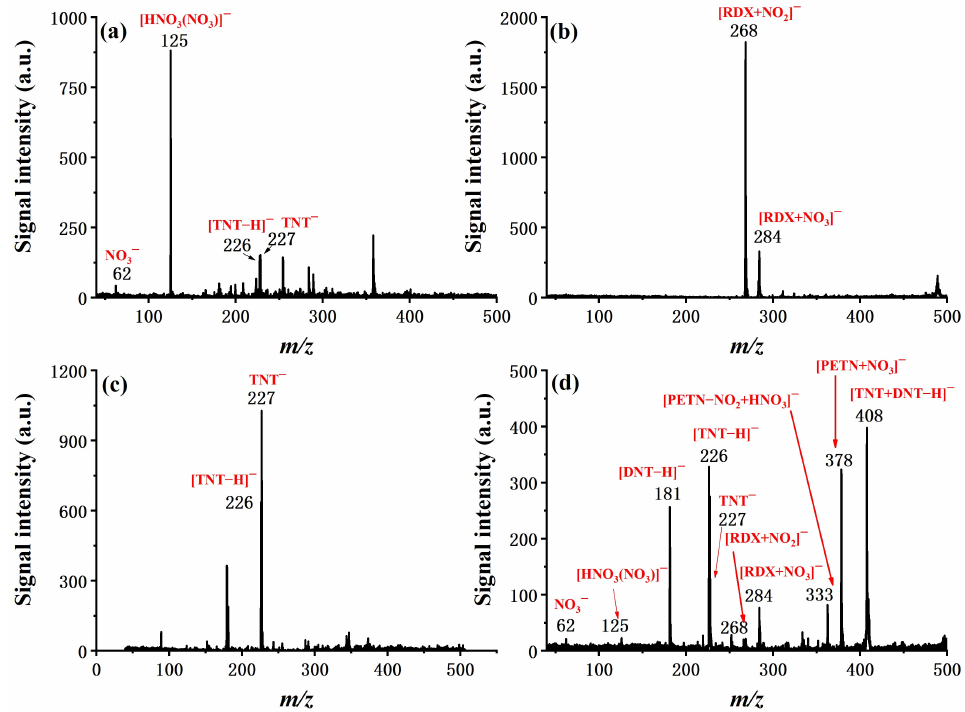
Figure 7. Detection and identification of explosives in mixture sample of ( a ) Amatol (AN, TNT, and wood powder), ( b ) C-4 (RDX, plastic binder, plasticizer, and taggant), ( c ) 1 ng TNT mixed with hand cream, and ( d ) mixture of TNT, 2,4-DNT, RDX, and PETN with an amount of 100 ng